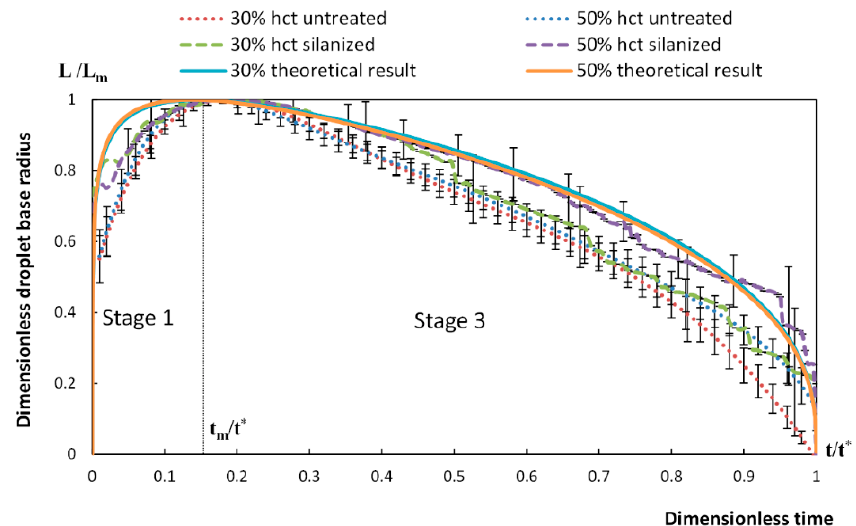
Figure 5. Dimensionless radius of the blood droplet base in the case of spreading over silanized and untreated Whatman 903 paper [29].